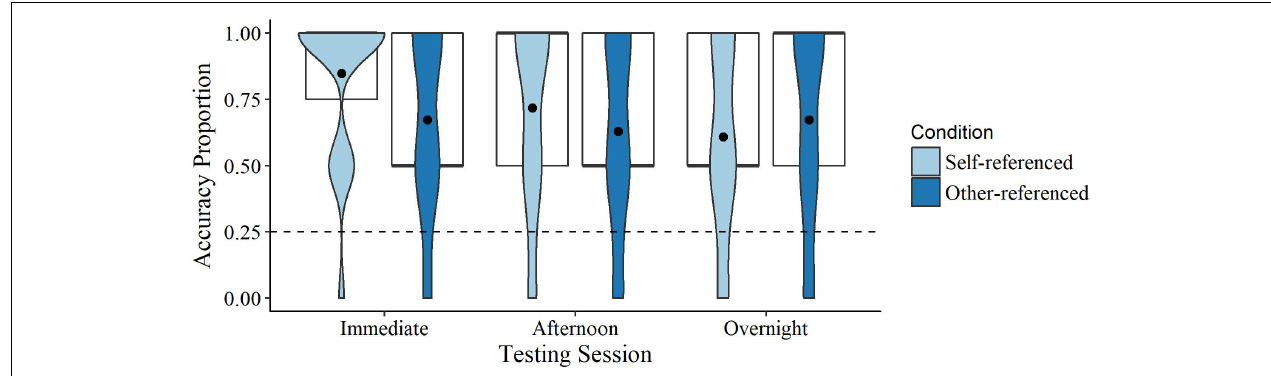
FIGURE 4 | Violin and boxplots of retention accuracy scores for self- and other-referenced items. Dots denote the means, bold lines the medians, and the dashed line chance (0.25).